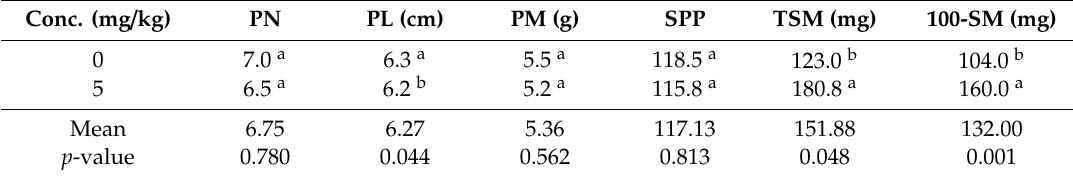
Table 2. Variation in reproductive traits after treatment with cadmium.